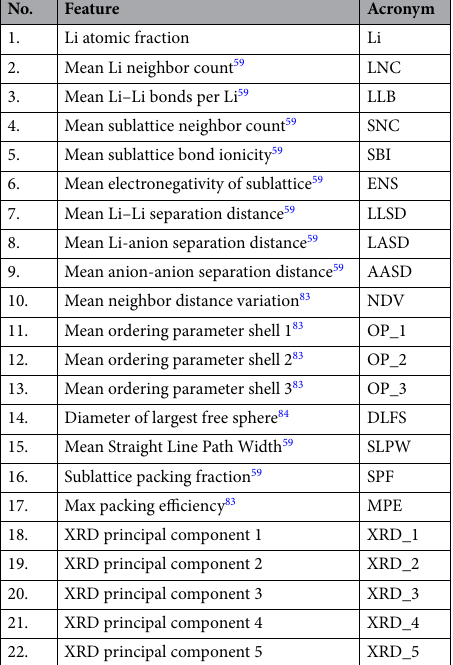
Table 1. List of 22 structure-based features used to predict 3D barriers for Li + migration in Li compounds. A complete description of the individual features can be found in Supplementary section